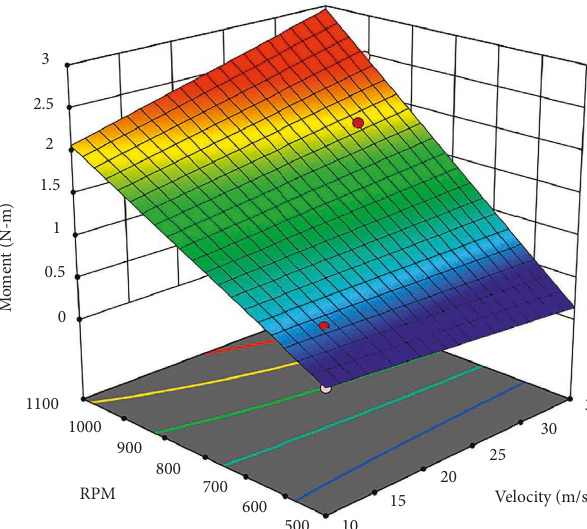
Figure 18: Moment measured for NASA SC(2)-0714 model.